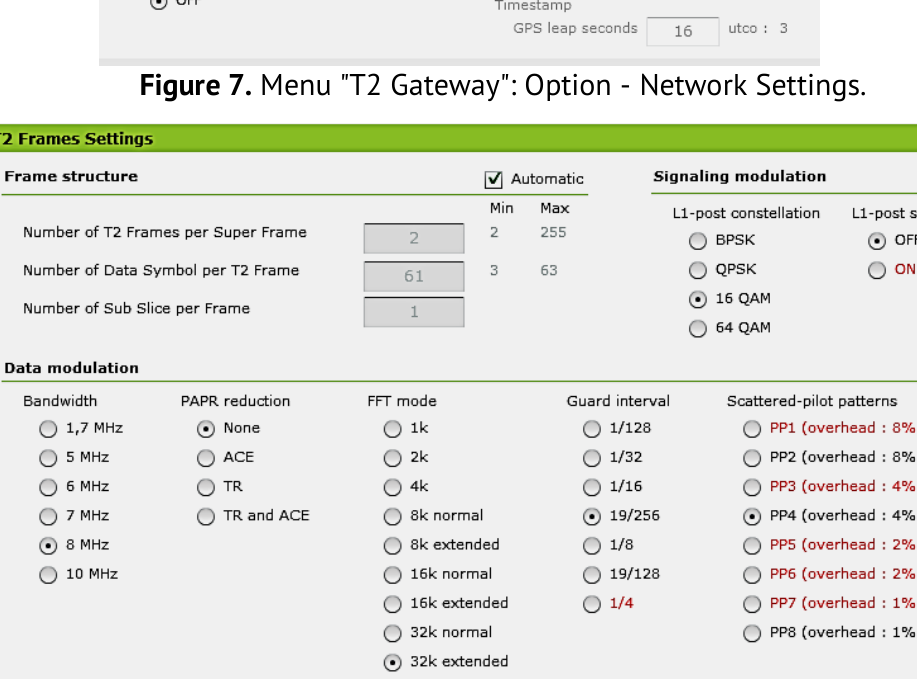
Figure 8. Menu "T2 Gateway": Option - T2 Frames Settings.